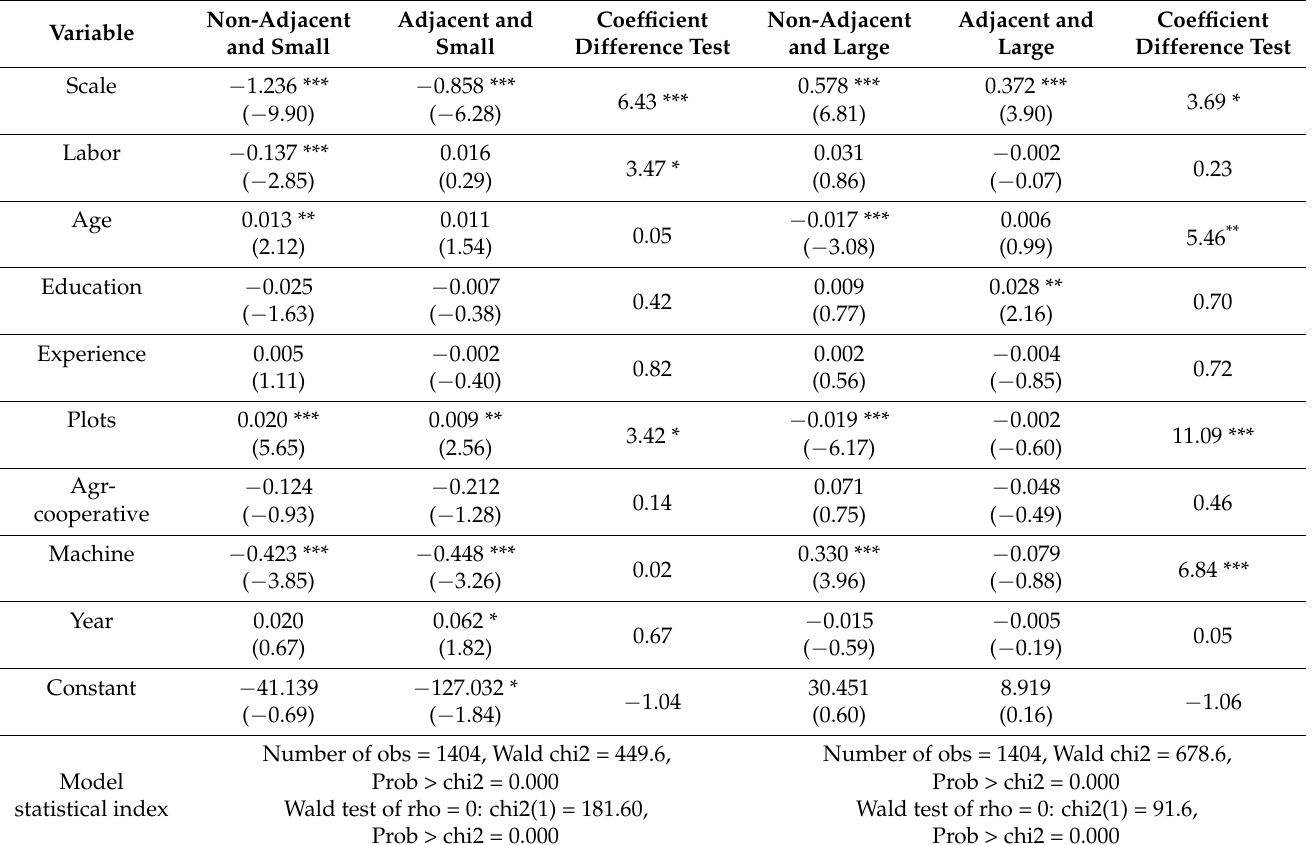
Table A1. Estimated results of the bivariate probit model of the influence of location on plot flow direction with different